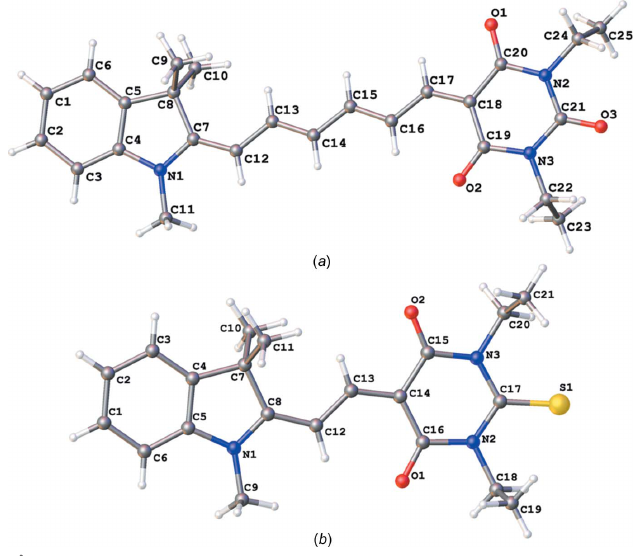
Figure 1 Views of the formula units of ( a ) TMI and ( b ) DTB with the atom- labelling schemes.